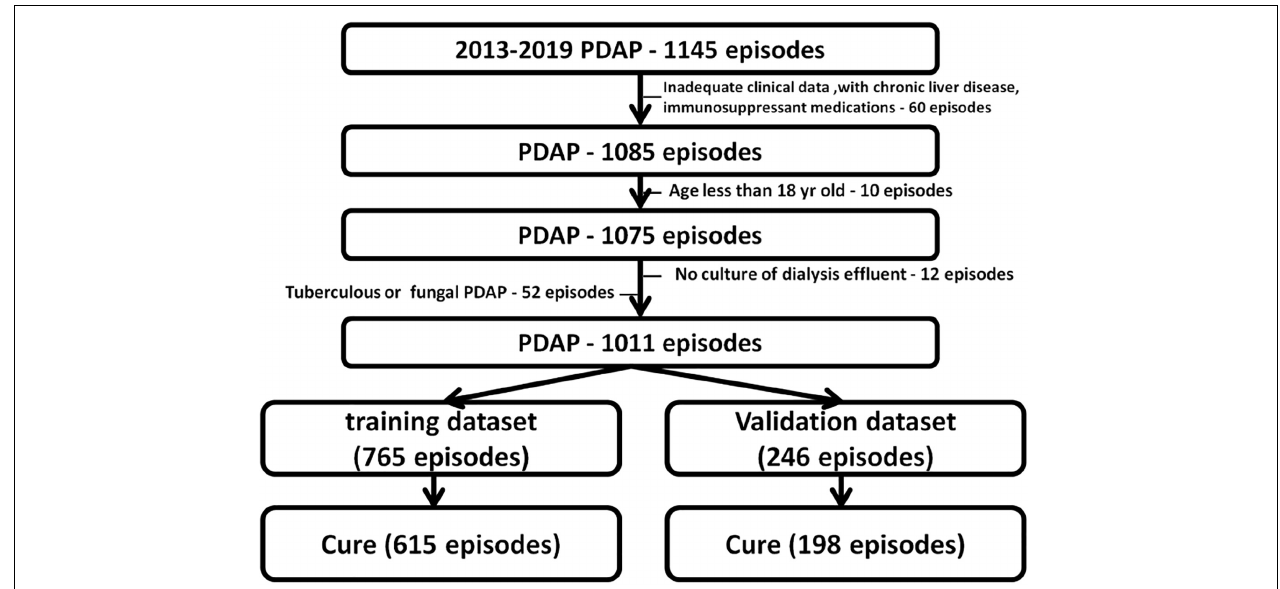
FIGURE 1 | Flowchart of cohort